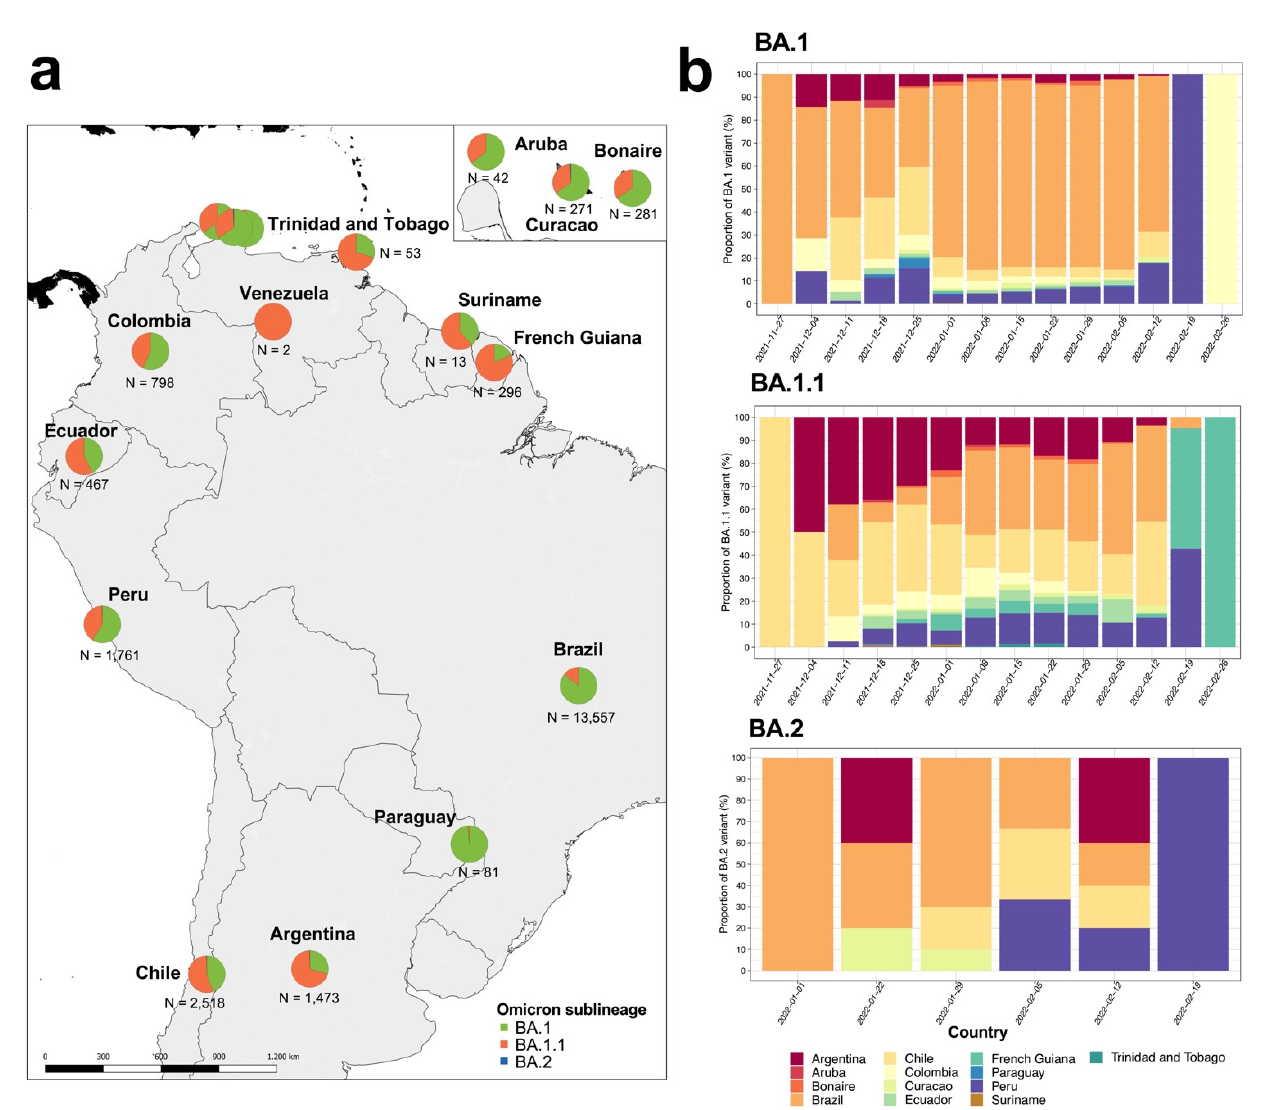
Figure 1. Descriptive analysis of Omicron sublineages circulating in South America. ( a ) The geo- graphical distribution, proportion and number of Omicron genomes for each country. ( b ) Temporal variations in the proportions of Omicron sublineages reported for each country.